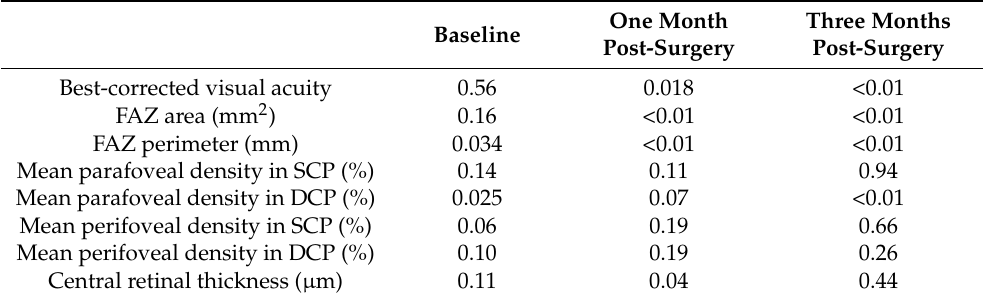
One Month Three Months Baseline Post-Surgery Post-Surgery